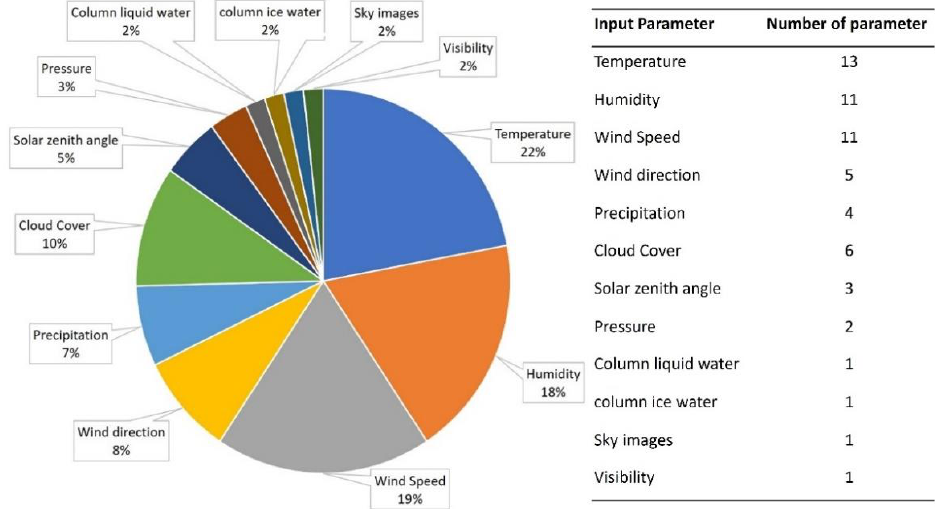
Figure 11. The number of publications based on the origin of data and forecast horizon.